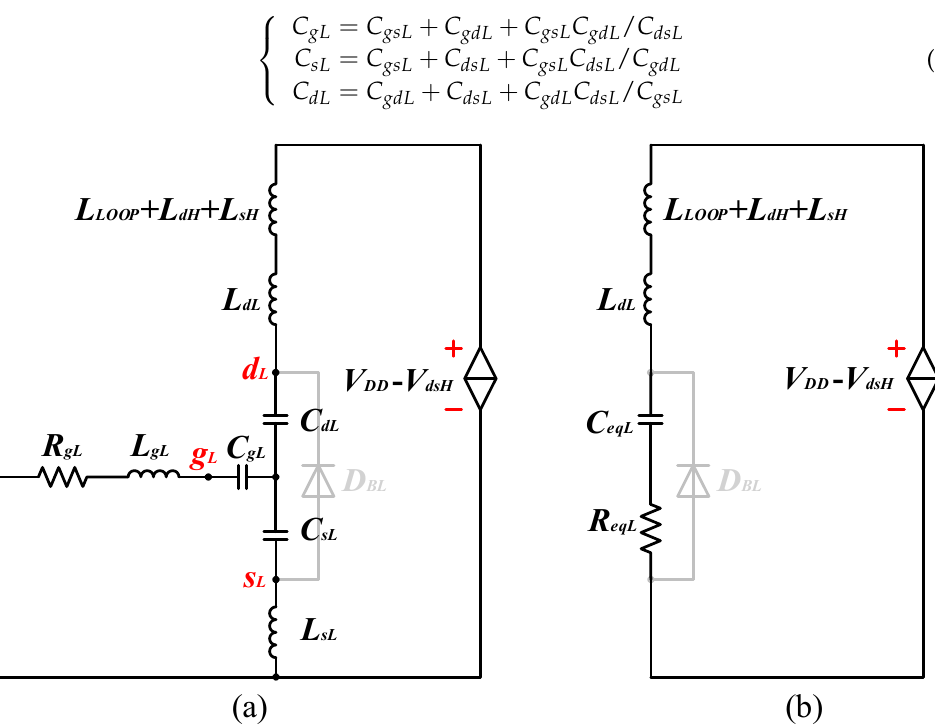
Figure 12. Simplified equivalent circuit for bridge-arm in Stage 3. ( a ) Star connection equivalent circuit; ( b ) Second-order equivalent circuit.